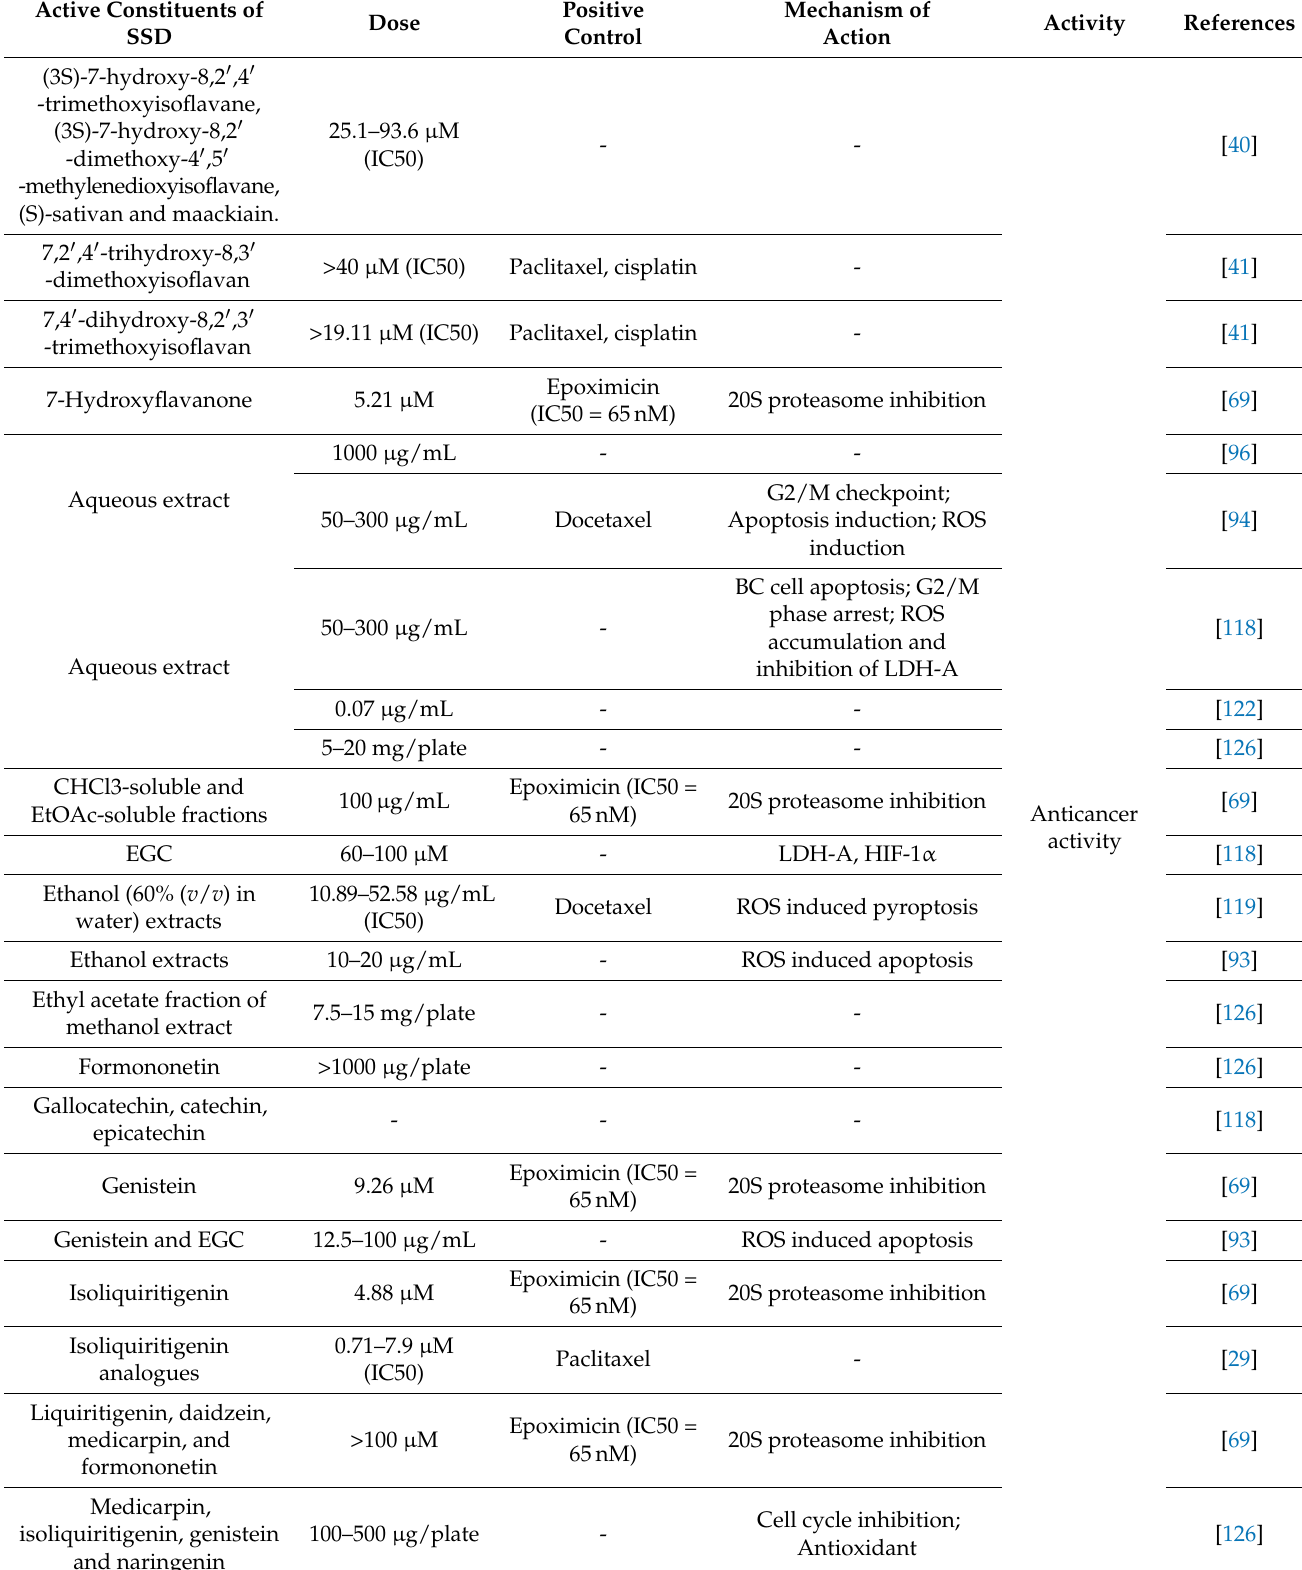
Table 2. In vitro anticancer activities of